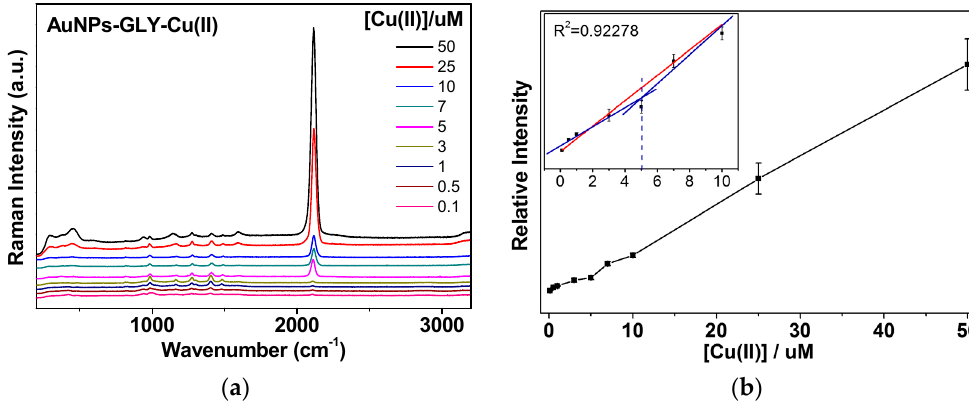
Figure 5. ( a ) Concentration-dependent SERS spectra of GLY depending on the [Cu 2+ ] concentration. Baseline corrections were made to compare the spectral bands; ( b ) Intensity plot of the CN intensities versus the [Cu 2+ ] concentration of 0–50 µM. The inset shows fitting the linear region between 0 and 10 µM.